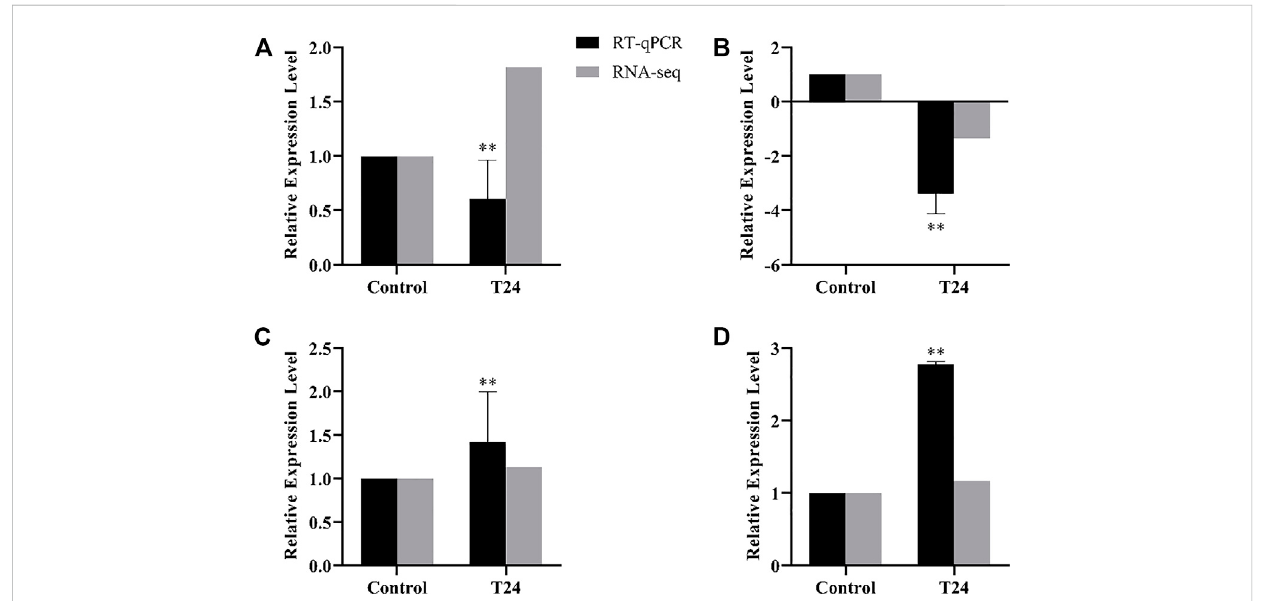
FIGURE 7 Control vs. T24. RT-qPCR results of RNA-Seq sequencing data of differentially expression genes (DEGs). Data in the fi gure are mean ± SD, and the asterisk above bars represents extremely signi fi cant difference between the treatment group and the control group of the gene relative expression level (* p < 0.05; ** p < 0.01; unpaired t -test). (A) : Mblk-1 , (B) : l(2)e fl , (C) : FoxP , (D) : FoxO.